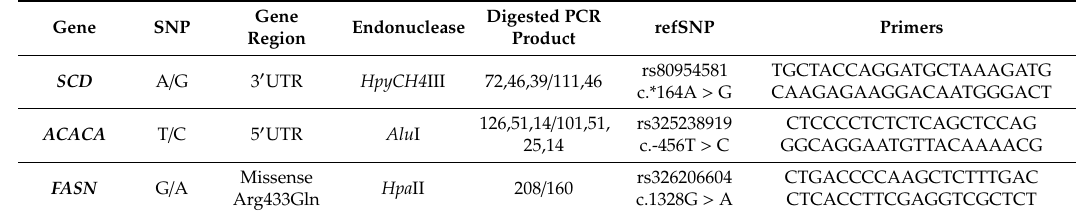
Table 1. The details of PCR-RFLP method used to identify the polymorphisms in analysed